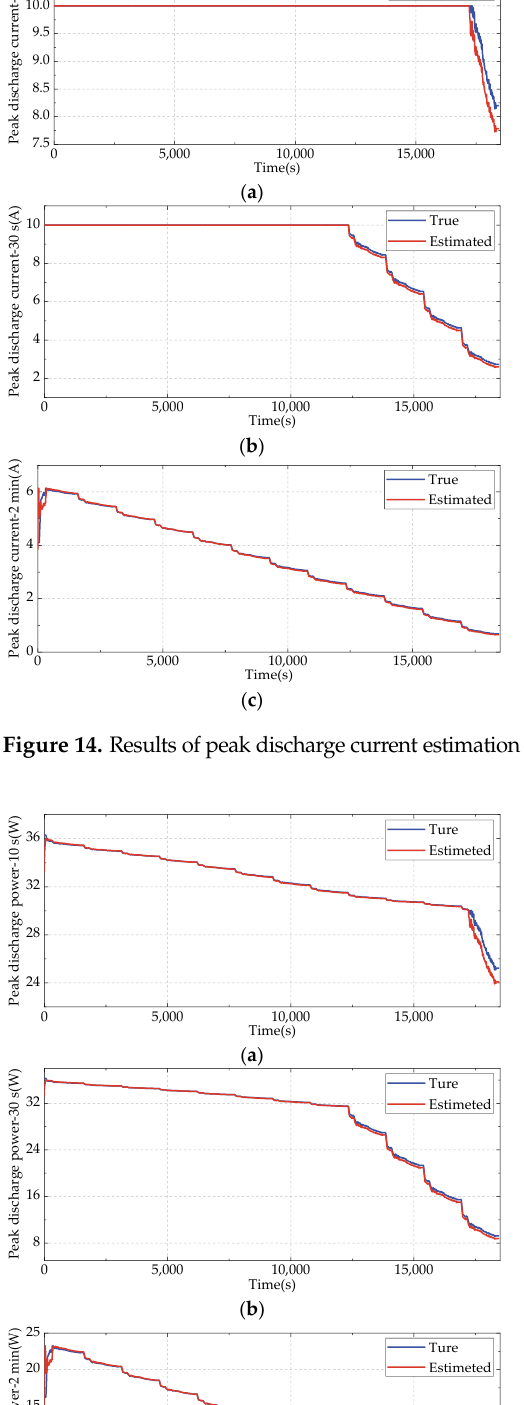
Figure 15. Results of peak discharge power estimation: ( a ) 10 s; ( b ) 30 s; ( c ) 2 min.